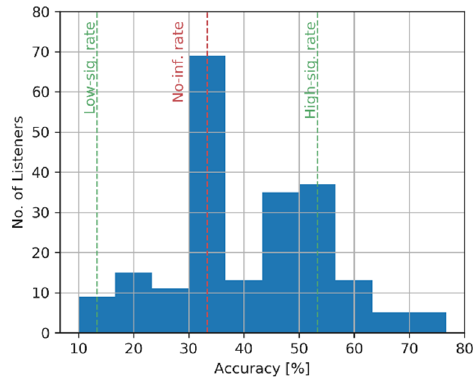
Figure 3. Histogram of the accuracy scores calculated for each listener.